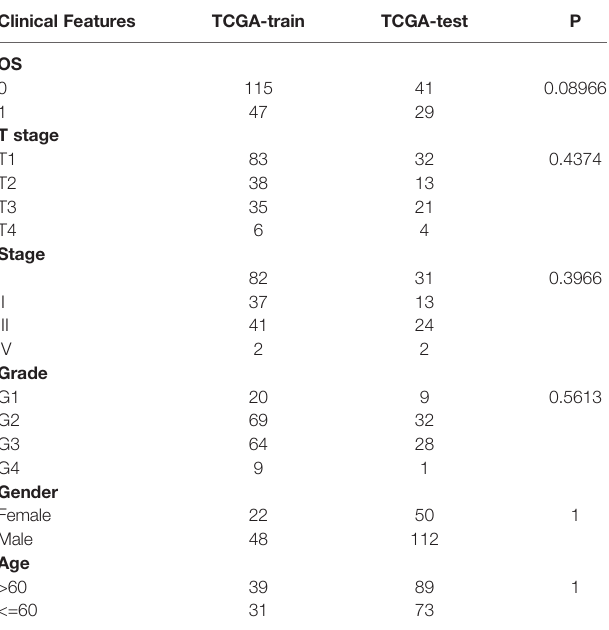
TABLE 2 | The sample information in training set and validation set. Clinical Features